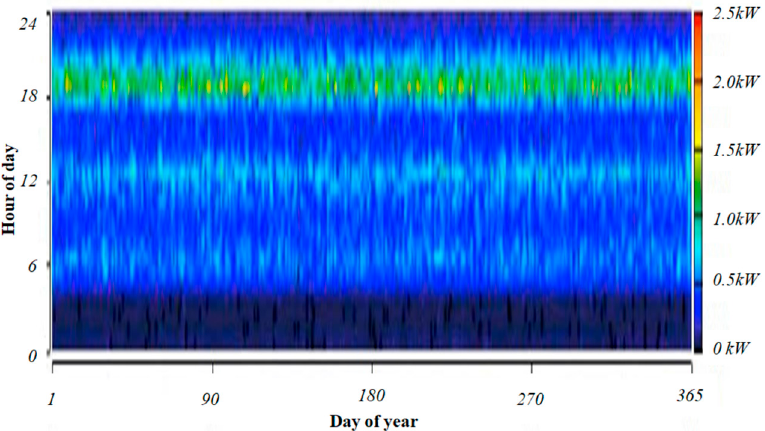
Figure 6. Yearly profile of 15 classrooms at SRM IST, Delhi-NCR Campus.